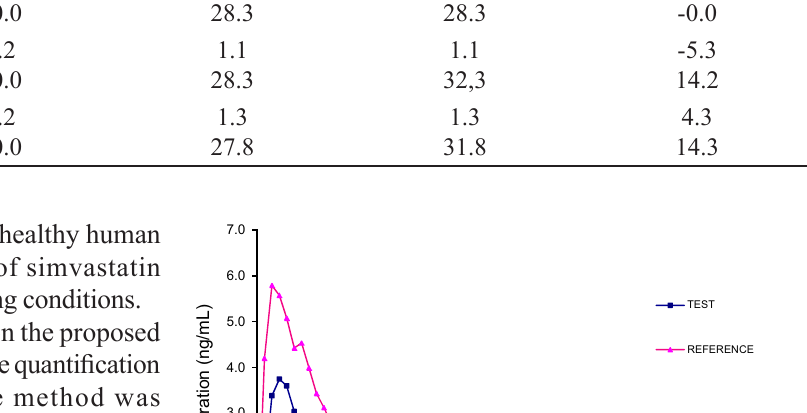
: area under the plasma concentration time curve from zero to the last nonzero concentration time; 0-t